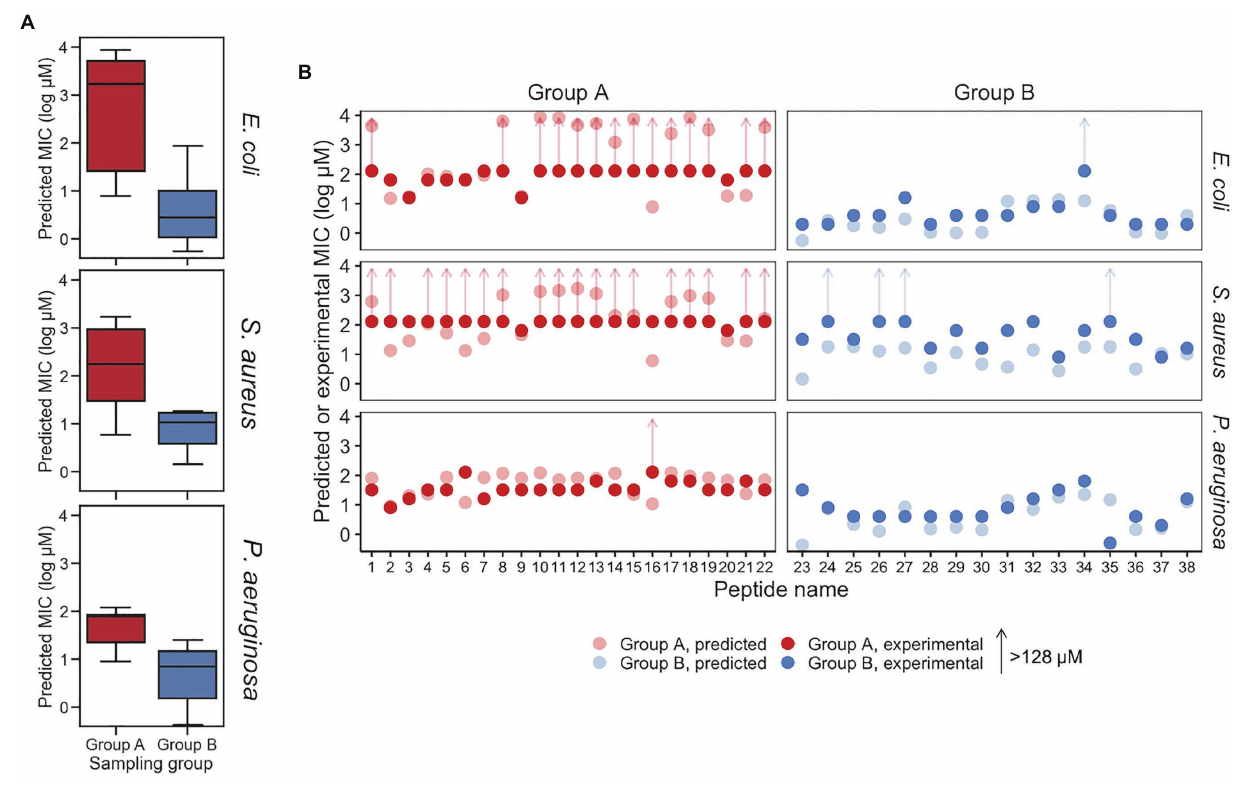
FIGURE 5 | Predicted and experimental MICs against E. coli , S. aureus , and P. aeruginosa . (A) Predicted MICs using the top-performing models for the Group A and Group B sampling groups are show in a boxplot, for E. coli , S. aureus , and P. aeruginosa , respectively. Group A and Group B are significantly different for each of the species ( p < 0.01). (B) Experimental MICs of Group A and Group B peptides against E. coli , S. aureus , and P. aeruginosa , with predicted MICs shown (with lighter coloring) for reference. Experimental MICs resulting in >128 μ M determinations are shown with arrows extending up from 128 μ M. All values are provided in Table 2